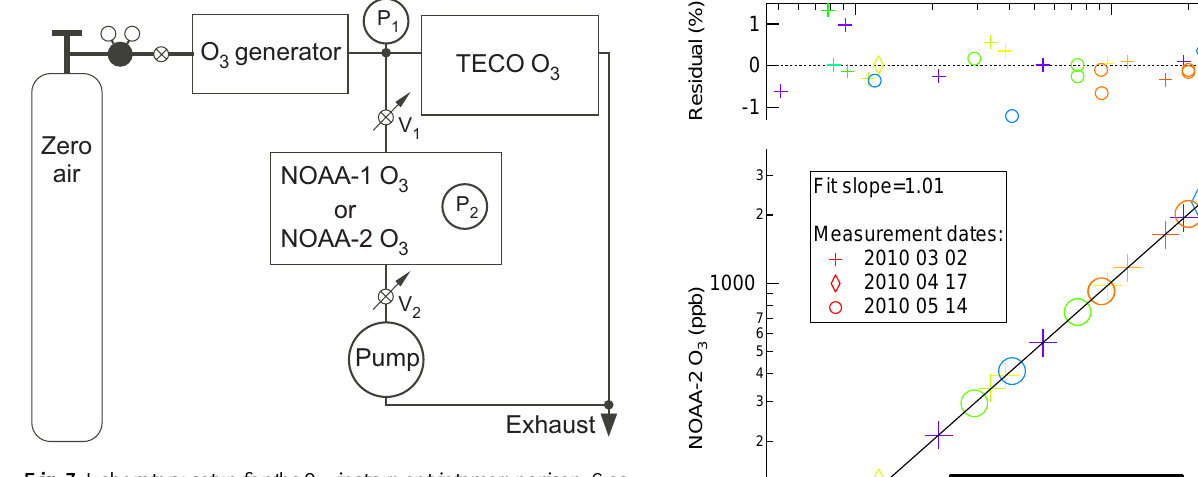
Fig. 7. Laboratory setup for the O 3 instrument intercomparison. Gas lines between the O 3 generator and O 3 instruments and valve V1 are made of PFA Teflon ® . V1 is used to ensure that pressure P 1 is always above laboratory ambient pressure. V2 is used to control the pressure inside the NOAA-1 or NOAA-2 O 3 instruments un- dergoing an intercomparison with the TECO Model 49i-PS primary standard instrument.